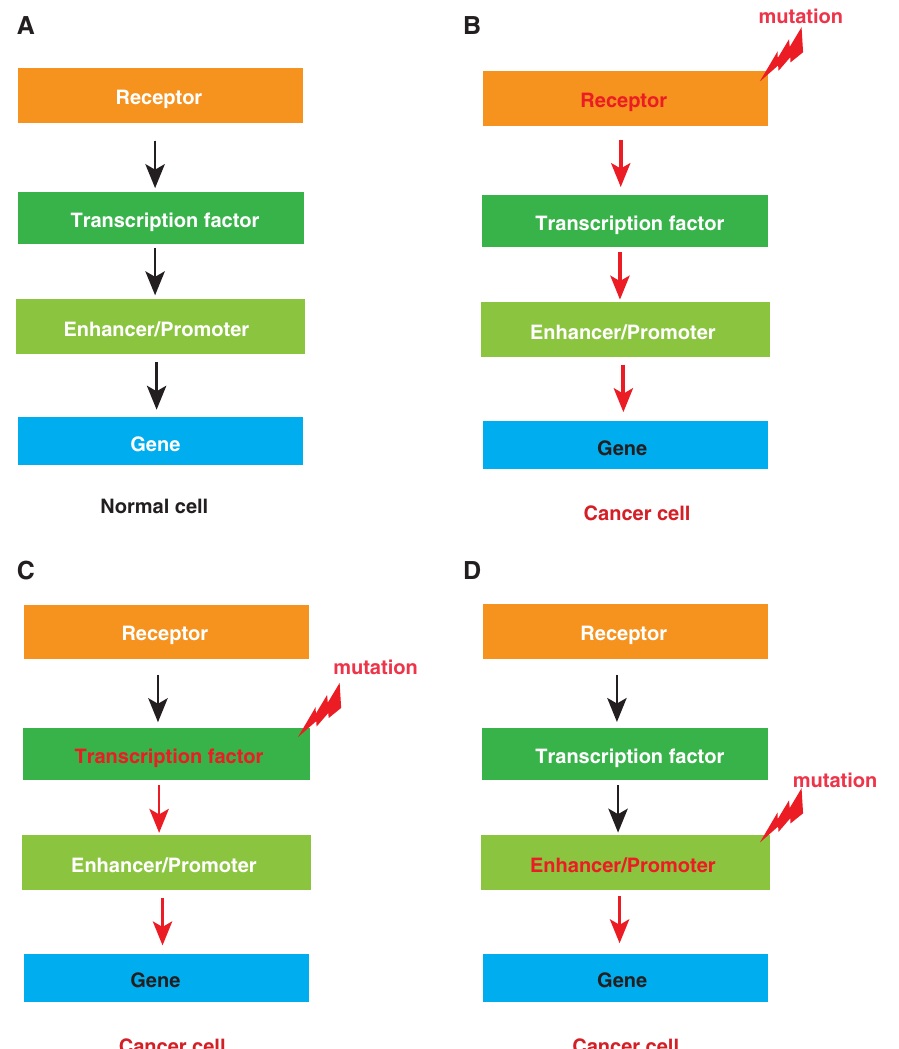
Fig. 2 a The hierarchy of signal-regulated expression of genes. Signal receptors activate distinct transcription factors through chemical modi fi cation of the latter (e.g., phosphorylation, acetylation, methylation, ubiquitination etc.). TFs bind with DNA sequence motifs in enhancers and promoters, which are associated with speci fi c genes in the genome. b – d Oncogenic mutations are common among signal receptors and signal-responsive TFs, enhancers, and promoters. When the factors at the higher level of the regulatory hierarchy are mutated, those at lower levels are often mobilized to activate aberrant gene expression programs in cancer